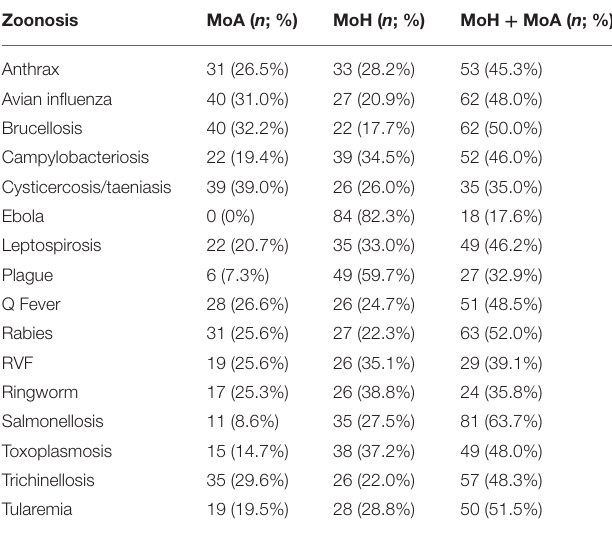
TABLE 1 | Zoonotic diseases controlled and monitored by the Ministry of Health (MoH) and/or Agriculture (MoA), according to respondents.